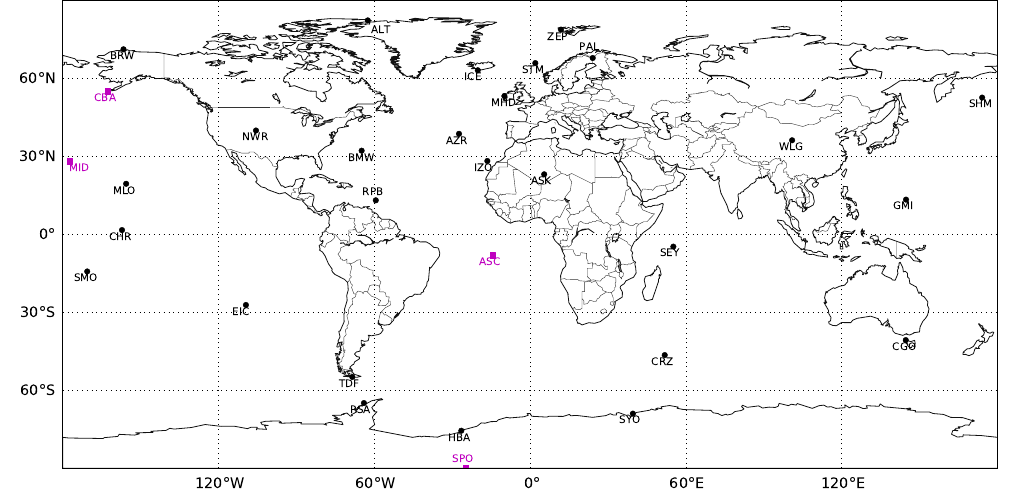
Fig. 1. Positioning of 31 NOAA surface sites (black circles). Purple squares represent stations for which prior and posterior simulations will be shown (Sect.